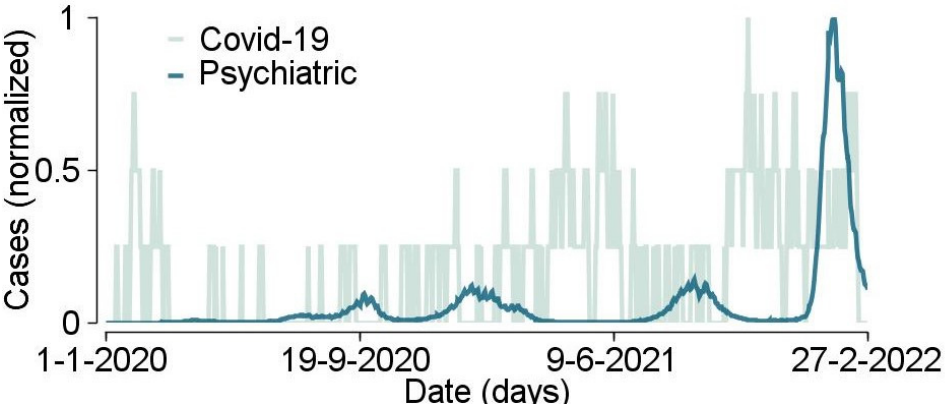
Figure 1. COVID-19 infection rates and suicide-related emergency room admissions in Israel, 1